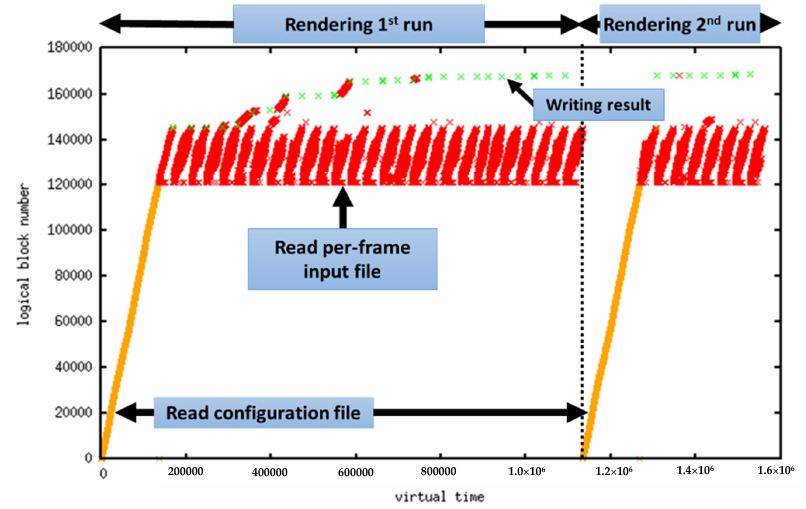
Figure 4. Block reference patterns in rendering process.